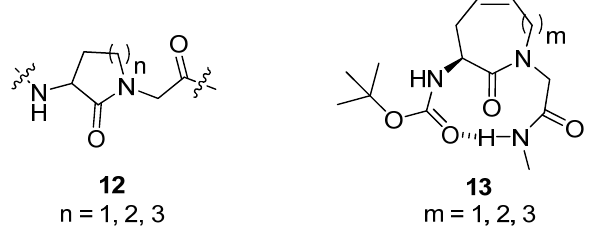
Figure 4. A conformational equilibrium involving a β -turn structure was observed for the dehydro-Freidinger lactam with a 9-membered